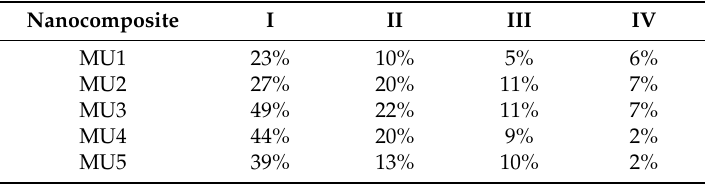
Figure 22. Angle of materials: ( a ) MU1; ( b ) MU3; and ( c ) MU5 right after the clamps were removed in the II set. Table 7. The percentage value of shape change of the investigated materials ( Δ 0 ) during the rest period.